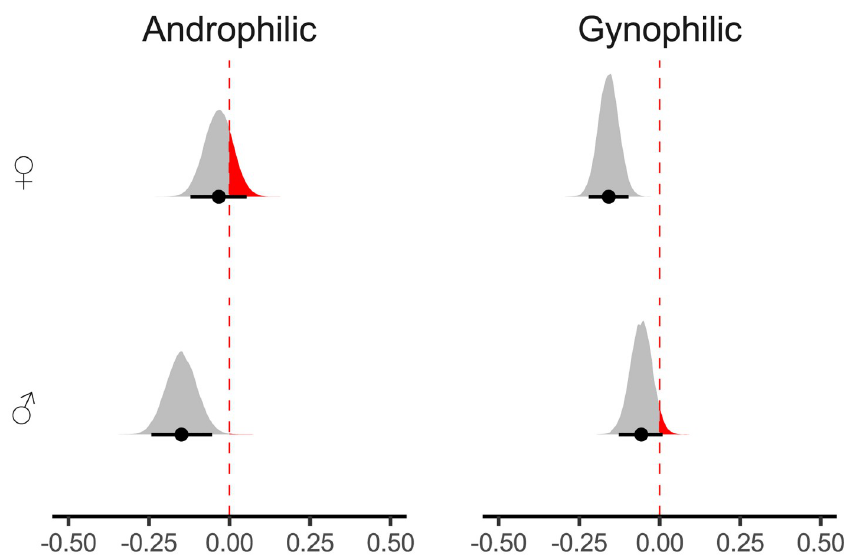
Fig 3. Posterior density plots with 95% high-density intervals, indicated by the error bars, and posterior medians for all approach-biases for reaction initiation time as predicted by the model. The red/black-area indicates the proportion of posterior samples opposite to the median and thus is a visual representation of the posterior median p- value. It quantifies the proportion of probability that the effect is zero or opposite given the data observed. The smaller the red areas are, the more reliable is the estimation of the